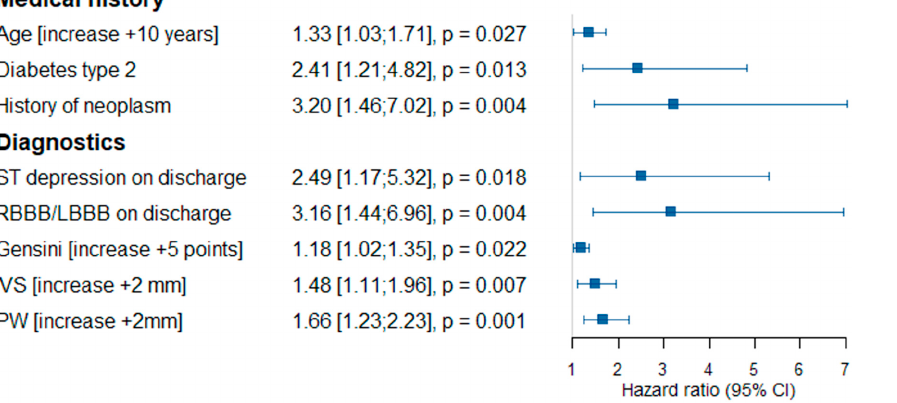
Figure 3. The univariate Cox proportional hazards model for primary composite endpoint occurrence. Abbreviations: HR—hazard ratio, RBBB—right bundle branch block, LBBB—left bundle branch block, IVS—intraventricular septum thickness, PW—posterior wall thickness.